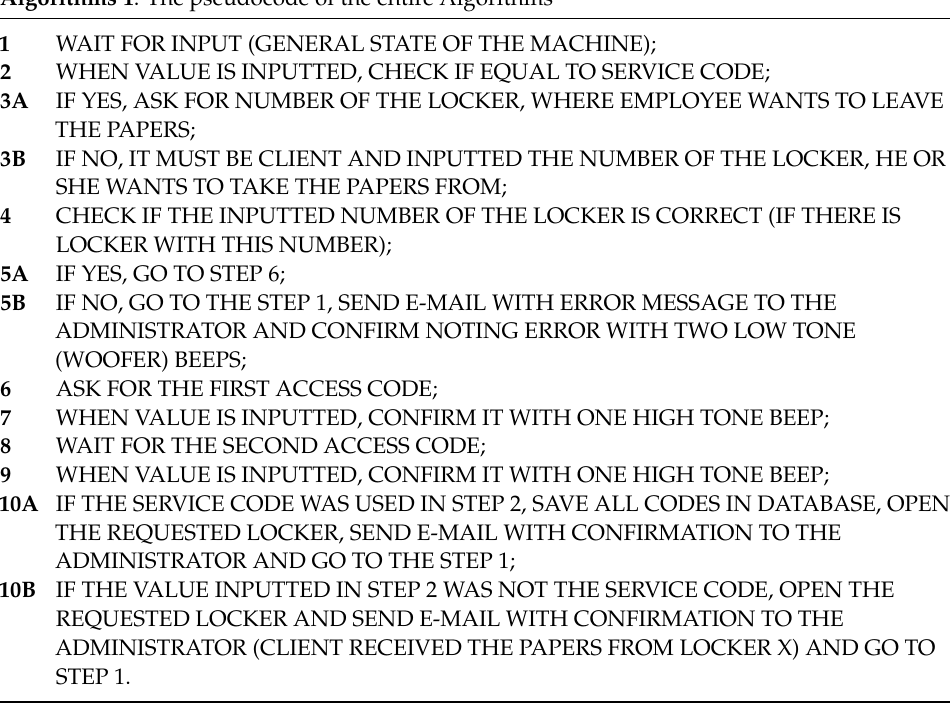
Algorithms 1 . The pseudocode of the entire Algorithms